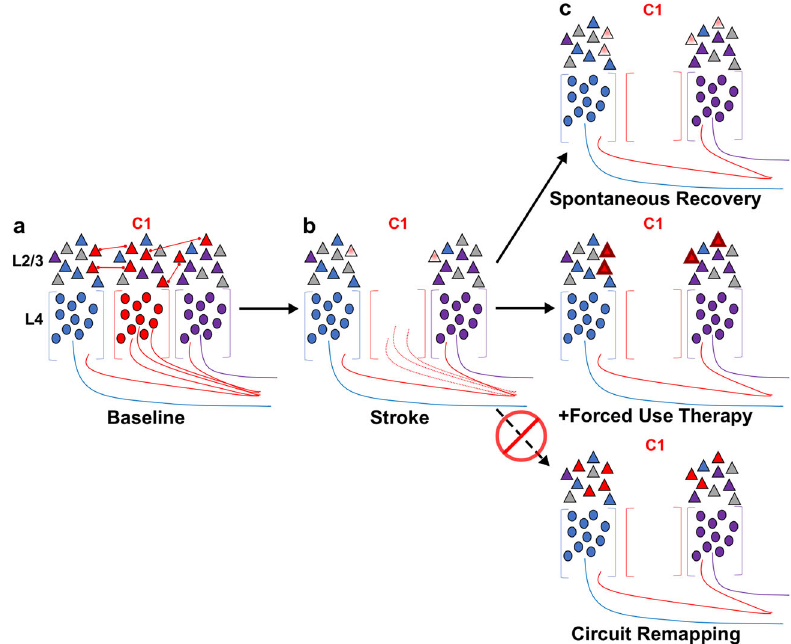
Fig. 7 Models of L2/3 whisker somatosensory circuit changes post-stroke. a Distribution of whisker-responsive L2/3 pyramidal neurons (triangles) in three adjacent barrels of the S1BF at baseline. Colors denote responsivity to a particular whisker (red = C1). Thalamocortical axons are depicted innervating L4 stellate neurons (circles) within barrels, with barrel septa pictured as brackets. Intracortical connections between similarly tuned L2/3 pyramidal neurons are depicted as well. Note that within a given barrel, L2/3 neurons are tuned to both the principal and surround whiskers. b After stroke targeting a single barrel, all neurons within the barrel are destroyed. The proportion of surround barrel neurons that are tuned to the C1 whisker (corresponding to the infarcted barrel) is decreased after stroke and their sensory-evoked responses are reduced (paler shading). c Spontaneous recovery (top panel) results in restoration of the proportion of surround barrel neurons tuned to the C1 whisker destroyed by stroke, but their sensory-evoked responses remain depressed, and there is no retuning of spared neurons to replace neurons lost to stroke. Forced use therapy (middle panel) after stroke restores and potentiates sensory-evoked responses in surround whisker neurons, but does not result in true circuit remapping with recruitment of new C1 whisker- responsive neurons (bottom